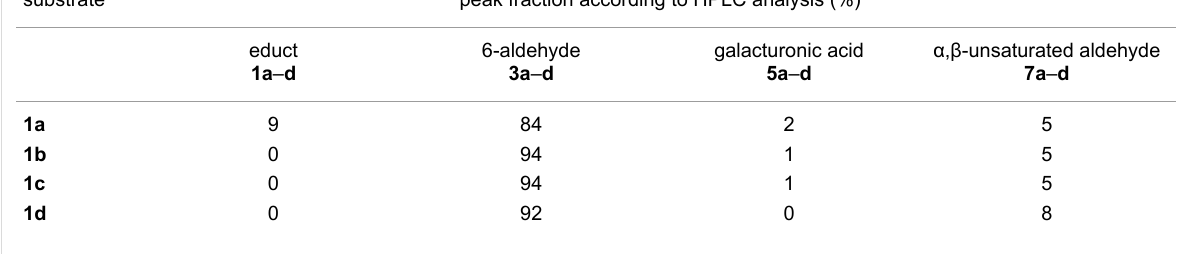
Table 1: Conversion of poly-LacNAc oligomers 1a – d with galactose oxidase under optimised conditions (pH 6, 24 h, 10 µmol substrate, 15.5 U galactose oxidase and 322 U peroxidase). The 6-aldehydes 3a – d were obtained in 84–94% yield. A small fraction of α , β -unsaturated aldehydes 5a – d was formed due to termination of the reaction by heating for 3 min at 95